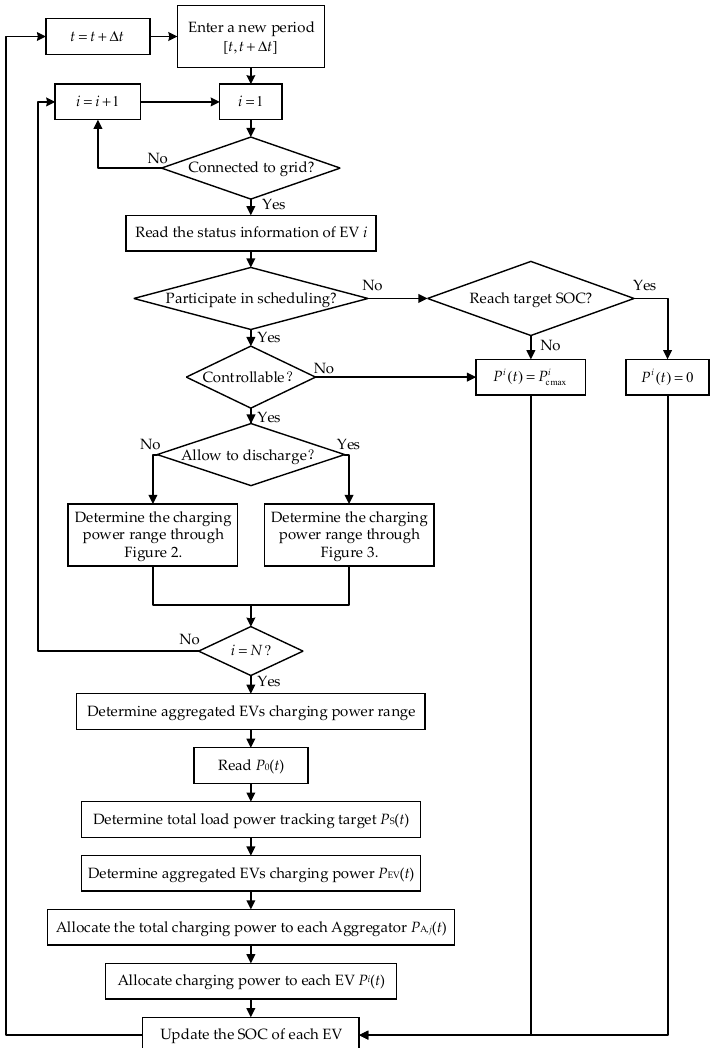
Figure 5. Control flowchart of aggregated EVs to smooth fluctuation.